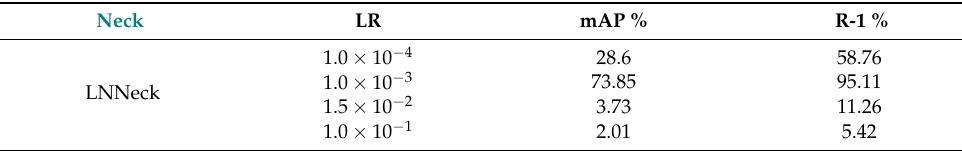
Table 9. Performances using the LNNeck and various learning